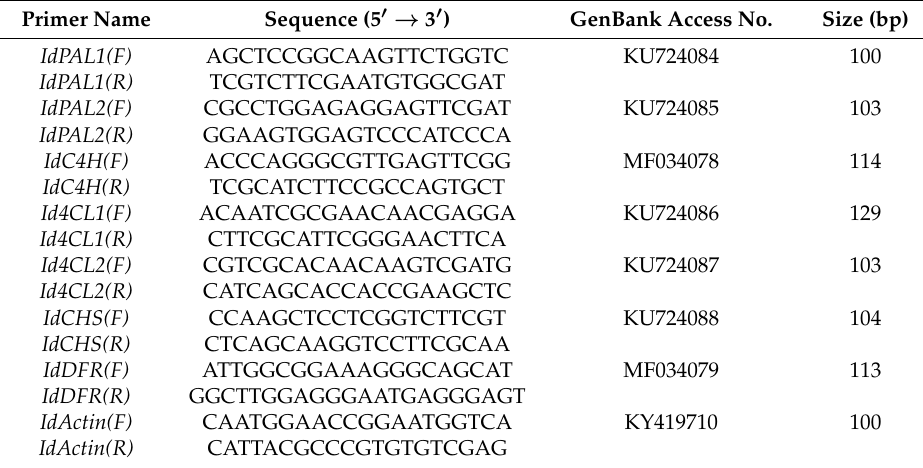
Table 1. Primers used in this